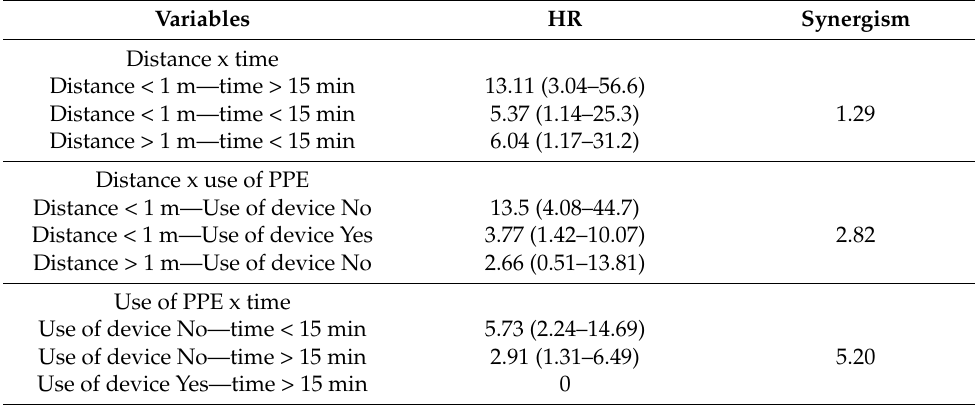
Table 2. Hazard ratio values by the combination of risk factor and synergy